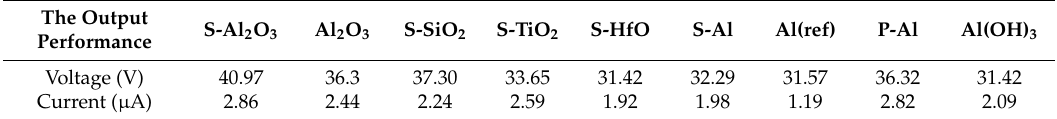
Table 1. Comparison of TENG output performance with various metal oxides and fabrication techniques (sputtering method: S-Al 2 O 3 , S-Al, S-TiO 2 , S-SiO 2 , S-HfO/Alkali treatment: Al(OH) 3 , dipping in water and drying: Al 2 O 3 , polishing: